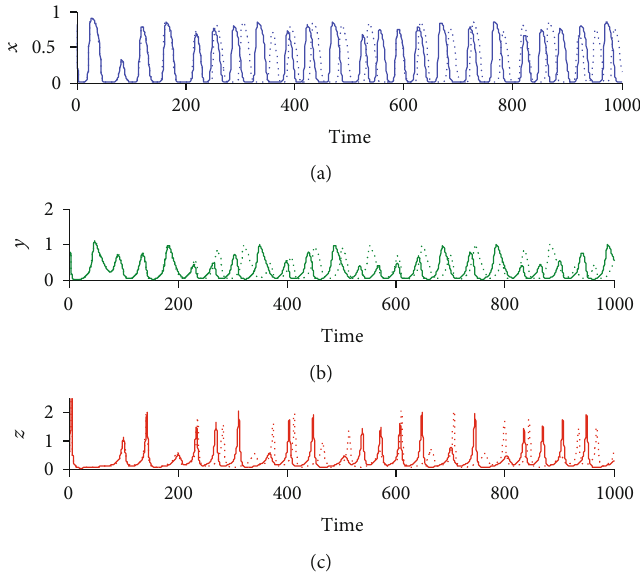
Figure 11: Sensitivity of the trajectory of the chaotic attractor that is given in Figure 9(a) to the initial values. Solid line starts at (0.8, 0.7, 0.6) while the dotted line starts at (0.81, 0.71, 0.61). (a) Trajectories of x versus t . (b) Trajectories of y versus t . (c) Trajectories of z versus t